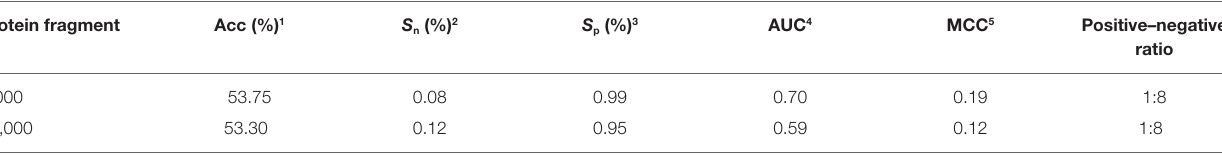
TABLE 4 | Results of testing Caps-Ubi under natural-distribution data. Protein